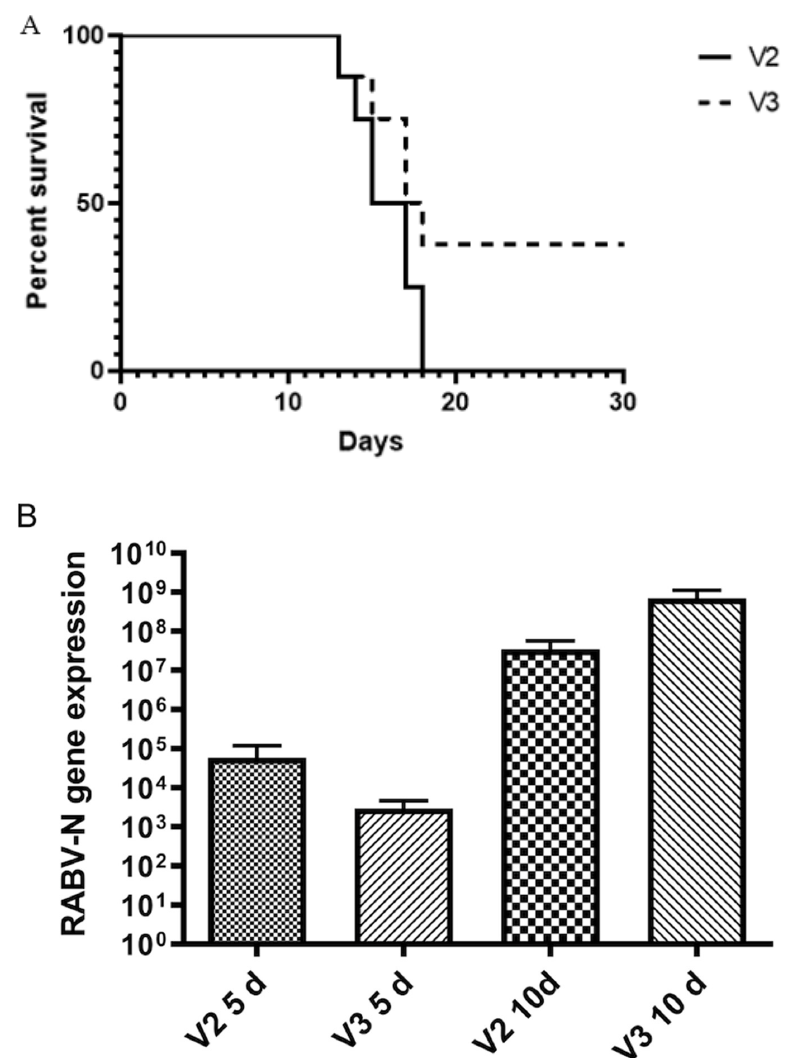
Figure 1. ( A ) Kaplan–Meier survival curve of mice infected with rabies virus (RABV) V2 (canine) and V3 (bat) with no statistic difference between groups. ( B ) RABV N gene expression mean in the brains of mice infected with 40 LD 50 V2 and 40 LD 50 V3. Mann–Whitney test was applied to